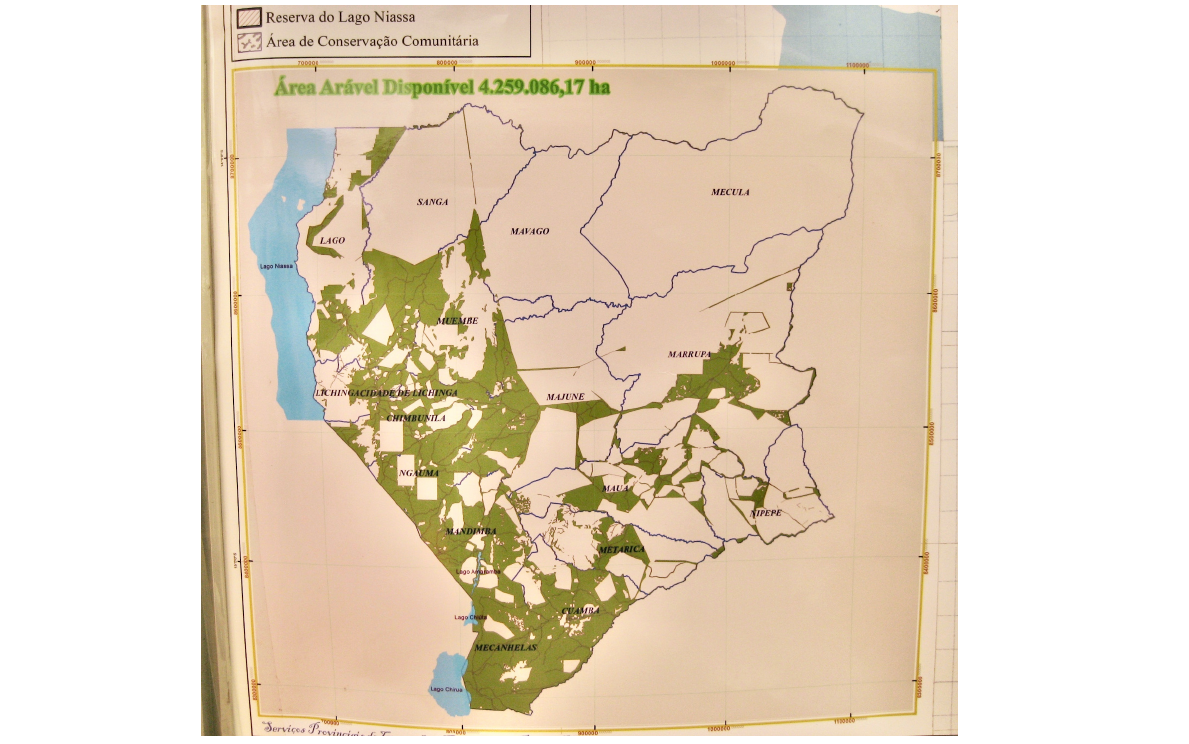
Fig. 2 . Map displayed at the Niassa provincial stand at the Maputo International Trade Fair (3 Sept